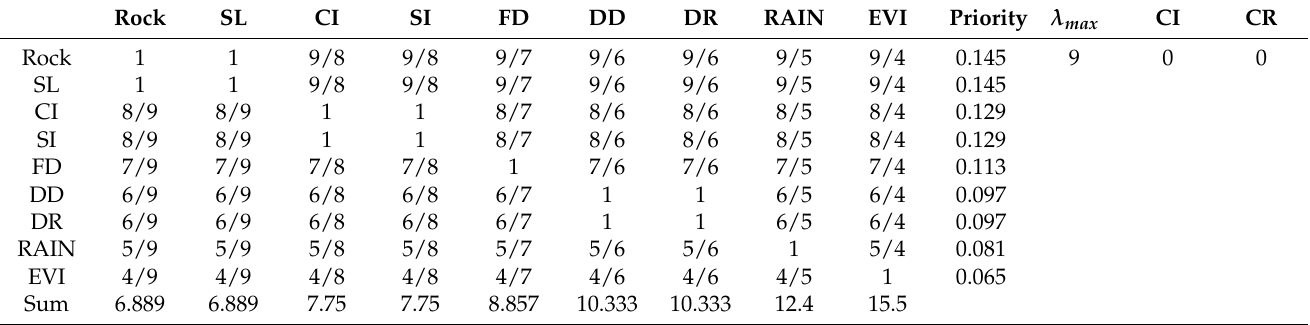
Table 6. Pairwise comparison matrix for the factors and consistency validation.